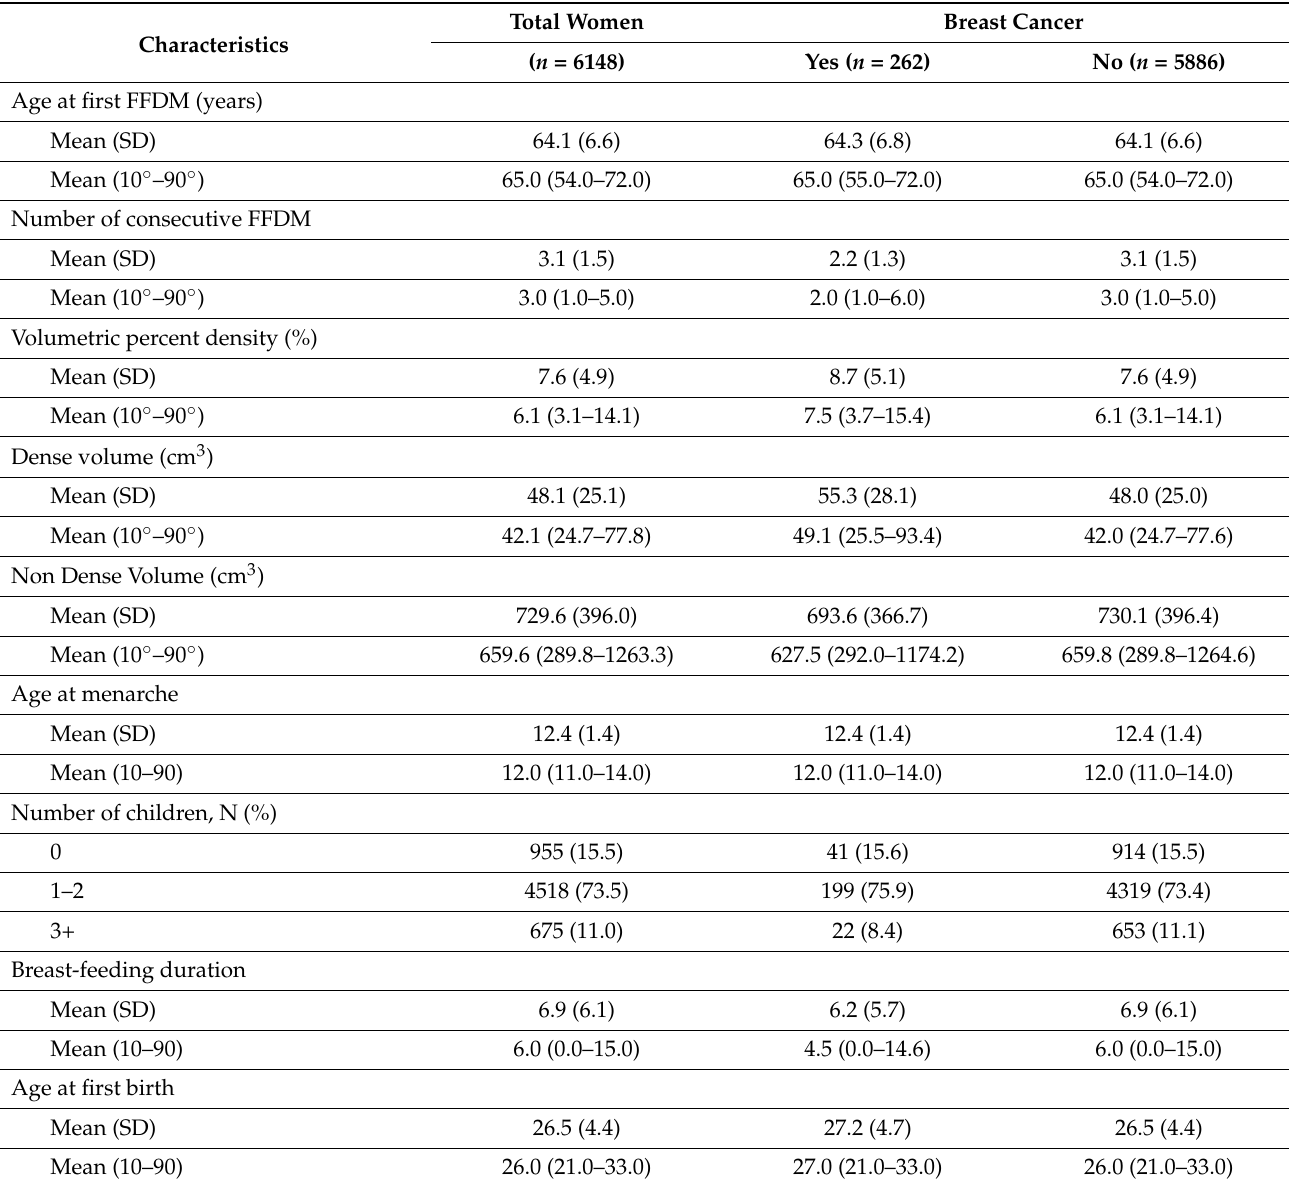
Table 1. Main characteristics of the 6148 women included in the FEDRA study separated by breast cancer